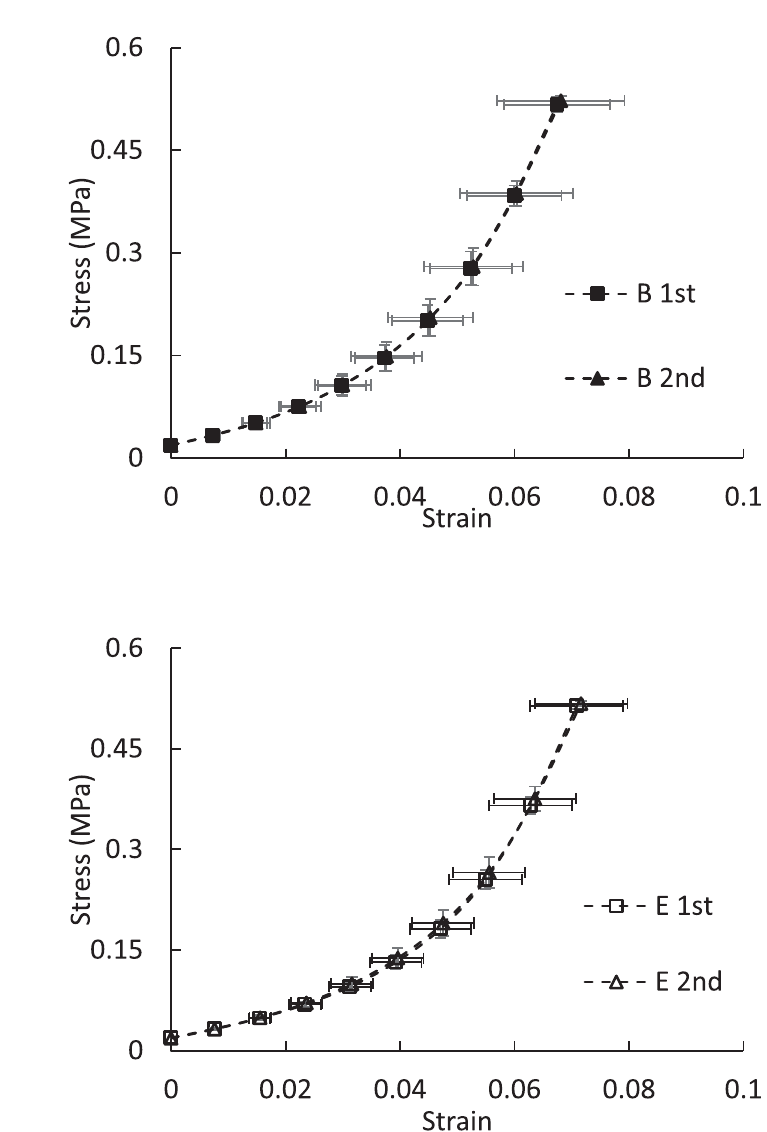
Fig 3. The stress-strain response of a) buffer-treated group and b) enzyme-treated group. The 1st and 2nd refer to tensile properties after 6-hour buffer incubation and additional 18-hour incubation in buffer/enzyme solution, respectively.